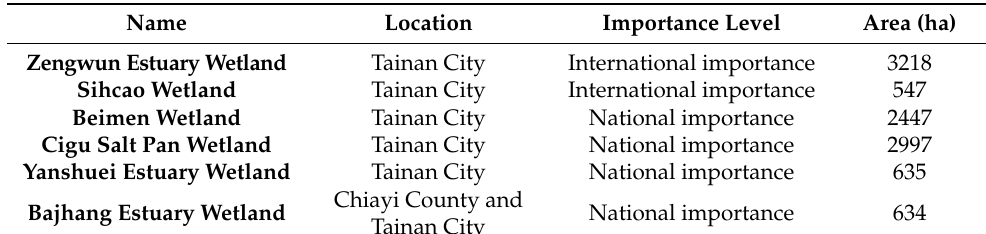
Table 1. The list of important Taiwan coastal wetlands. 1